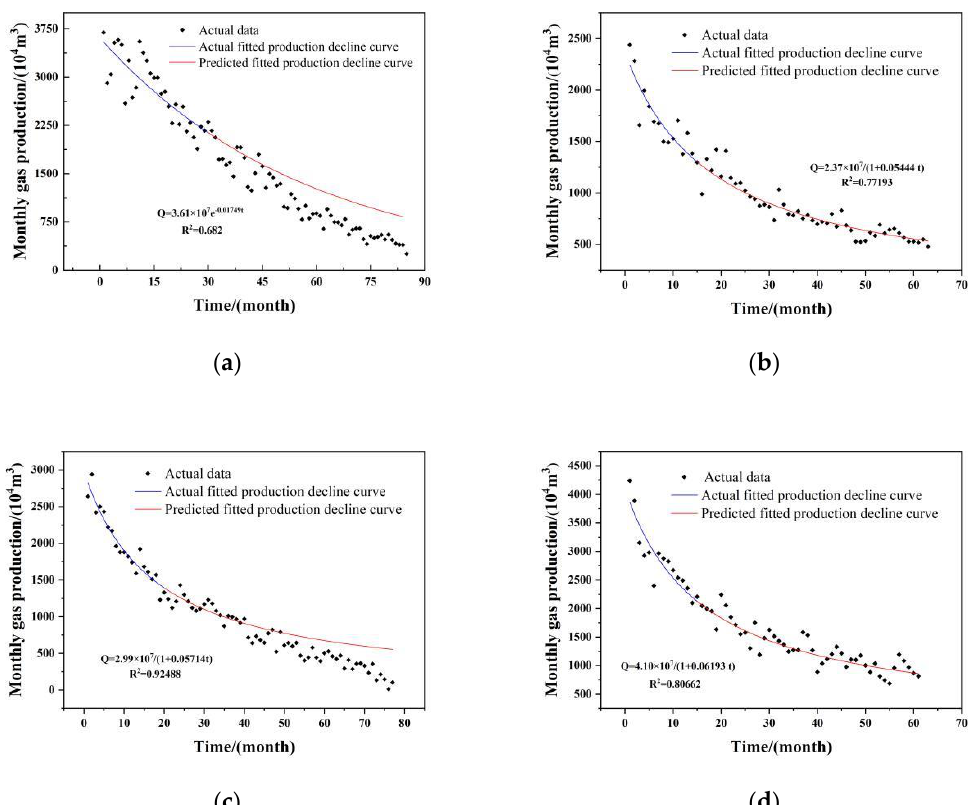
Figure 3. Curves of production decline and actual production of typical gas wells in the Changbei block. ( a ) Well CX-2. ( b ) Well CX-5. ( c ) Well CX-6. ( d ) Well CX-10. block. ( a ) Well CX-2. ( b ) Well CX-5. ( c ) Well CX-6. ( d ) Well